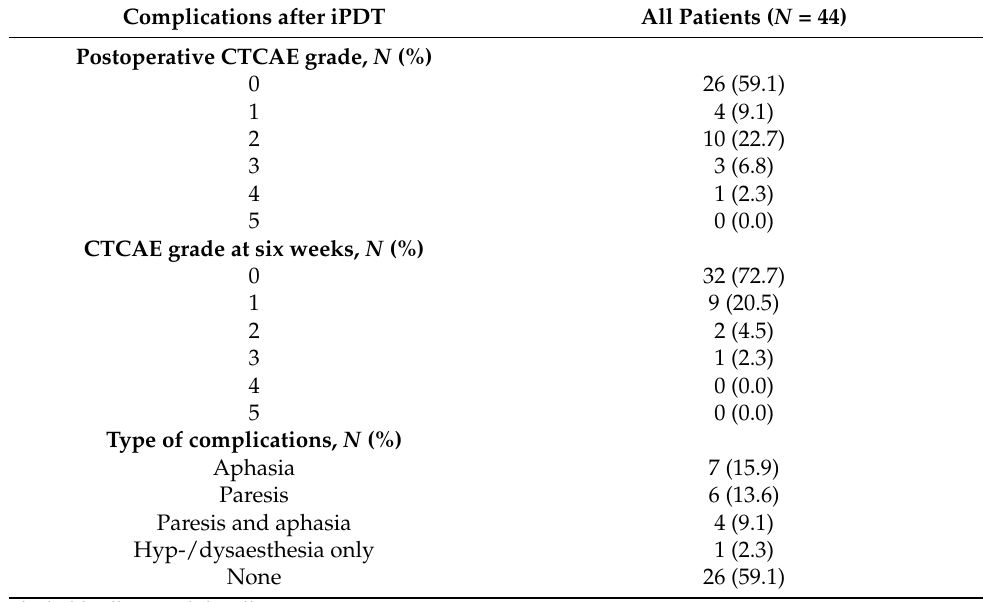
Table 3. Complications after